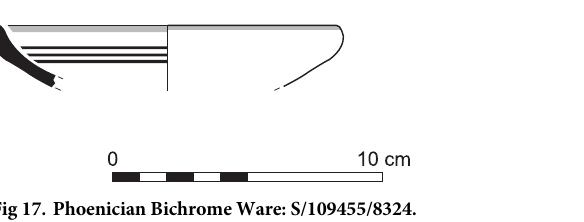
Fig 16. Phoenician Bichrome Ware: S/109470/8324.